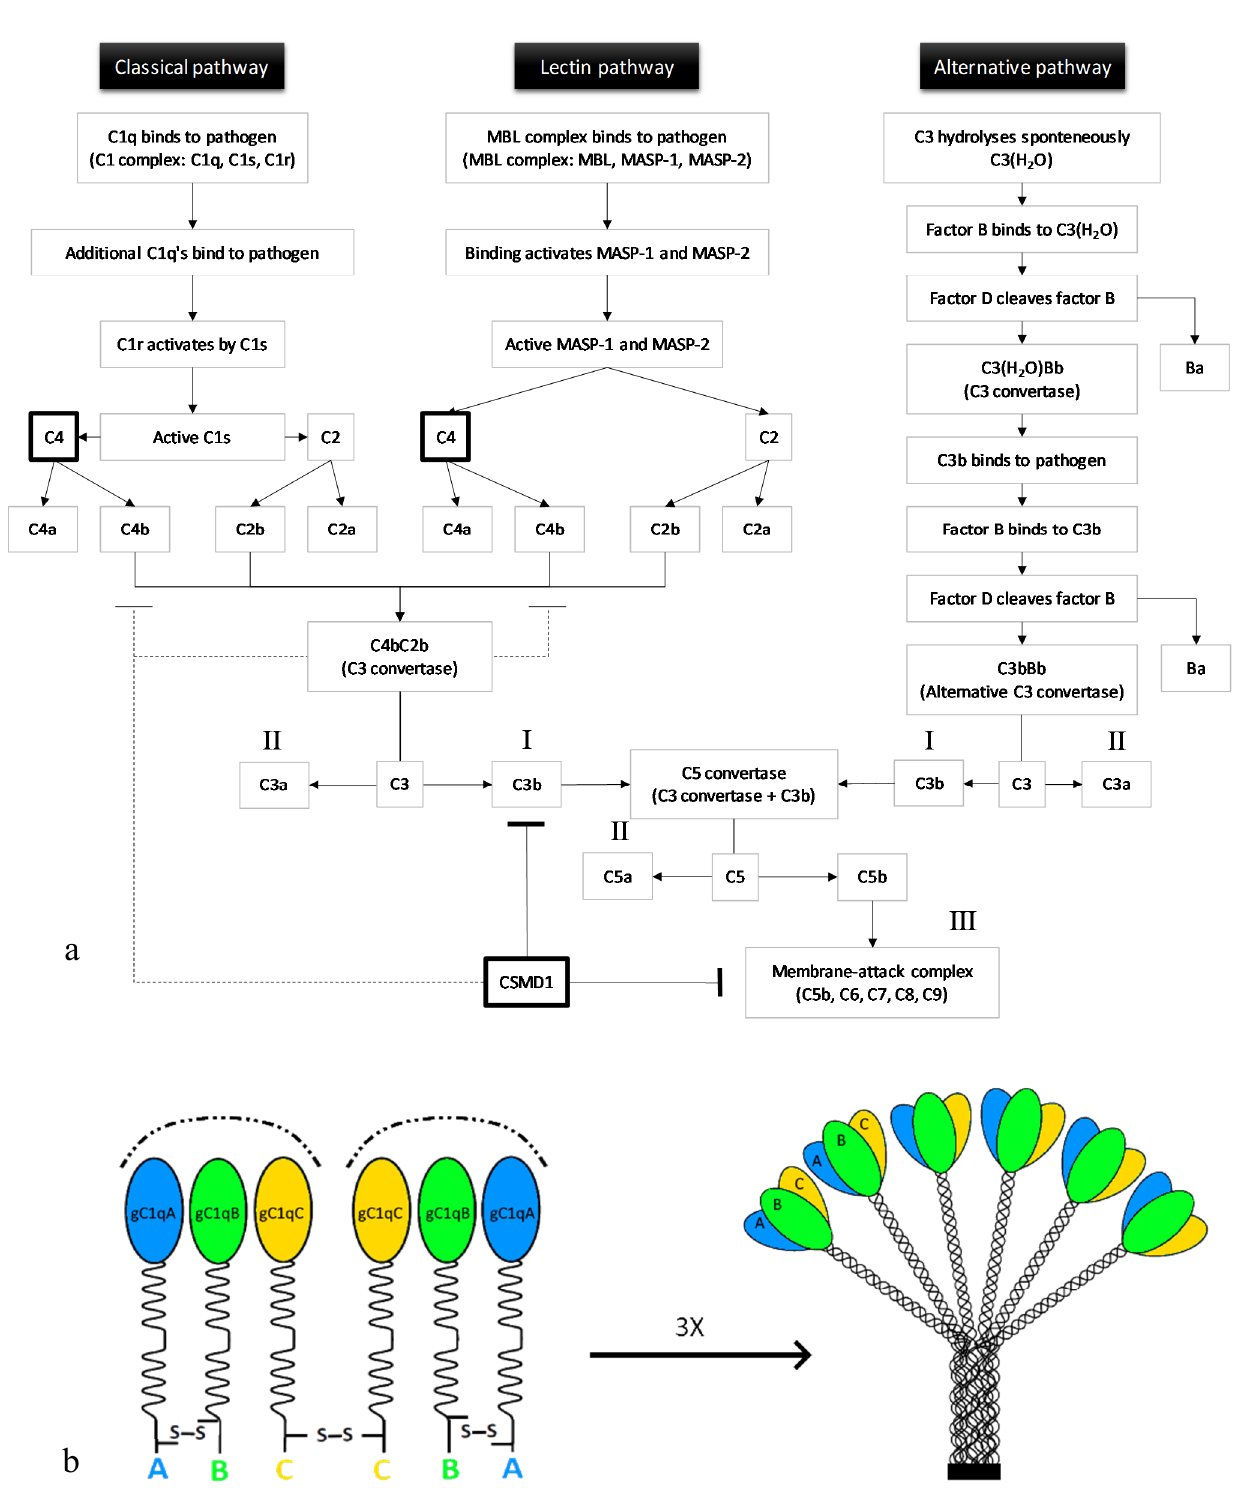
Figure 1. ( a ) The three pathways of the complement system. All three pathways can lead to C3b opsonisation of a target cell through the formation of a C3 convertase (C4bC2b or C3bBb). Subsequently, the C5 convertase can be formed by binding of C3b to a C3 convertase. C5b, together with C6, C7, C8, and a C9-polymer, generates the membrane attack complex (MAC). A tight regulation of the complement activation is needed to protect healthy host cells from phagocytosis and cell lysis. ( b ) Visualisation of the complement protein C1q composition. C1q consists of three peptide chains (A, B, and C). Disulfide bridges (S-S) connect the N-terminals of A- and B-chains and two C-chains. The C-terminals are globular domains (gC1qA, gC1qB, and gC1qC) that recognise immune targets. Adapted from Frachet et al. (2015) [19].